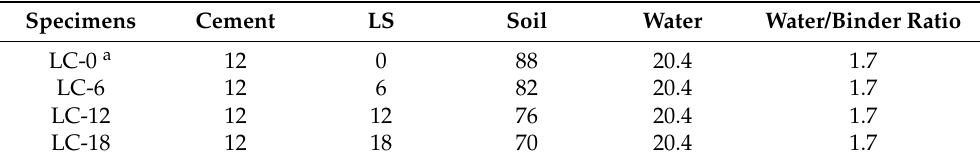
Table 4. Mix proportion of specimens (mass %).